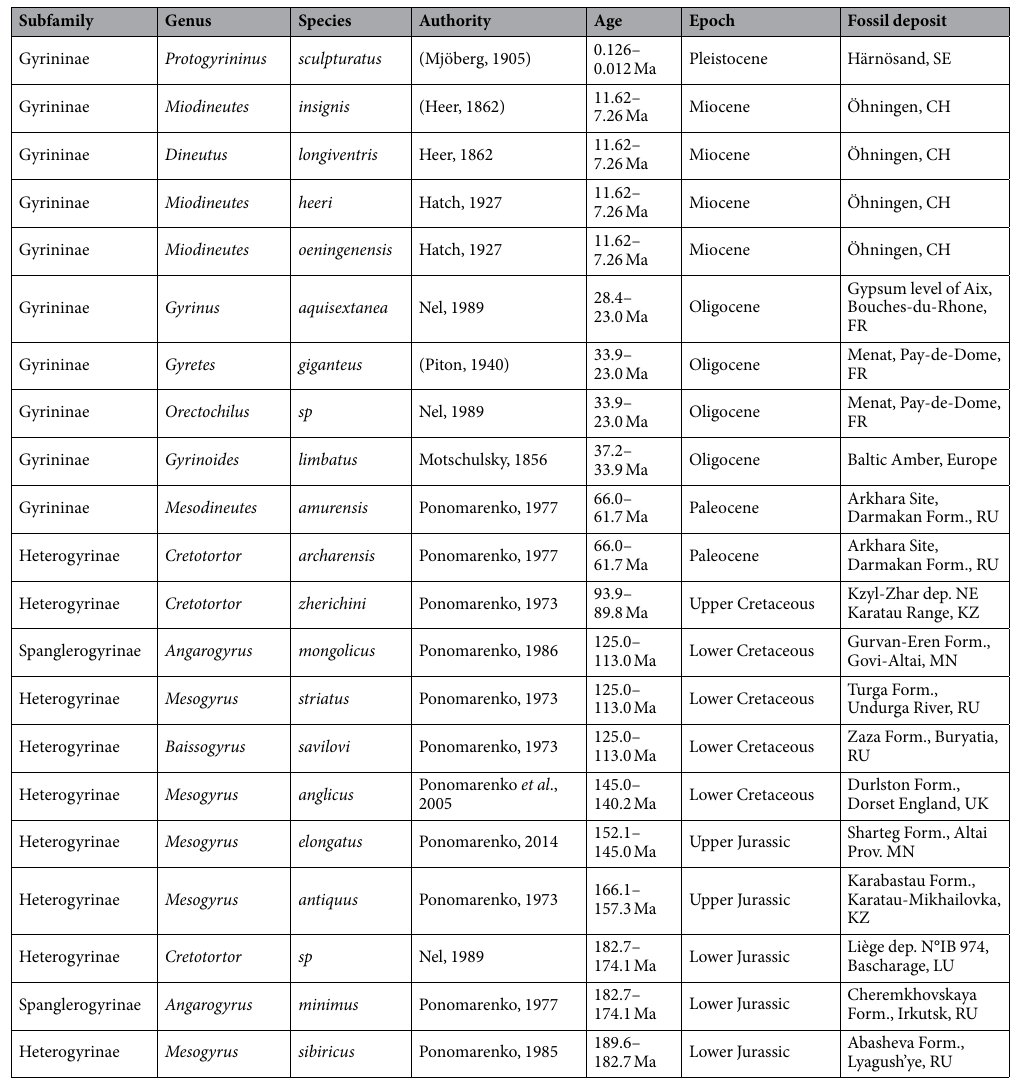
Table 1. Inferred subfamily of known fossil